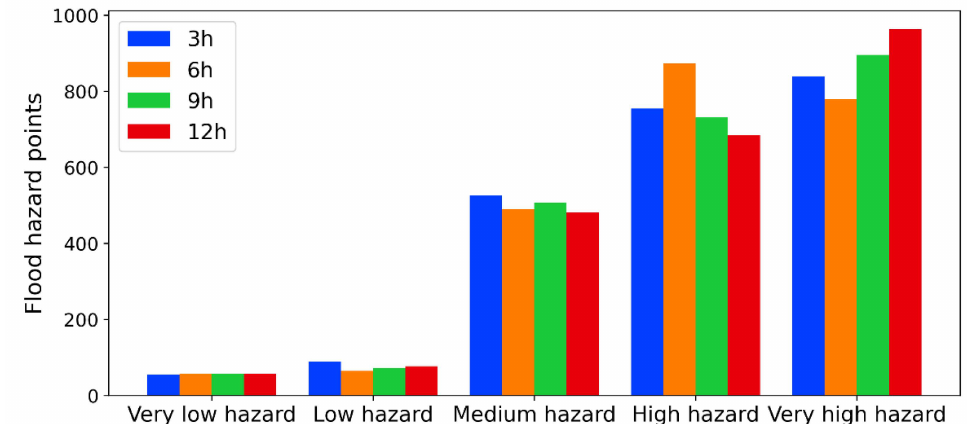
Figure 9. Number of historical flood points in each hazard zone under four rainfall